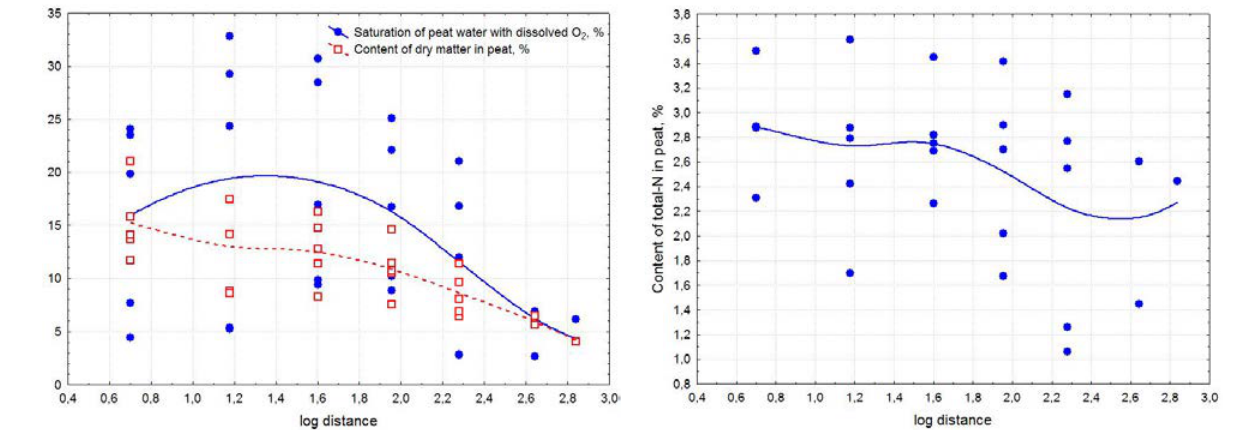
Figure 8. Relationships between saturation of peat water with dissolved O 2 and content of dry matter in peat, and log-distance from the cutoff ditch.